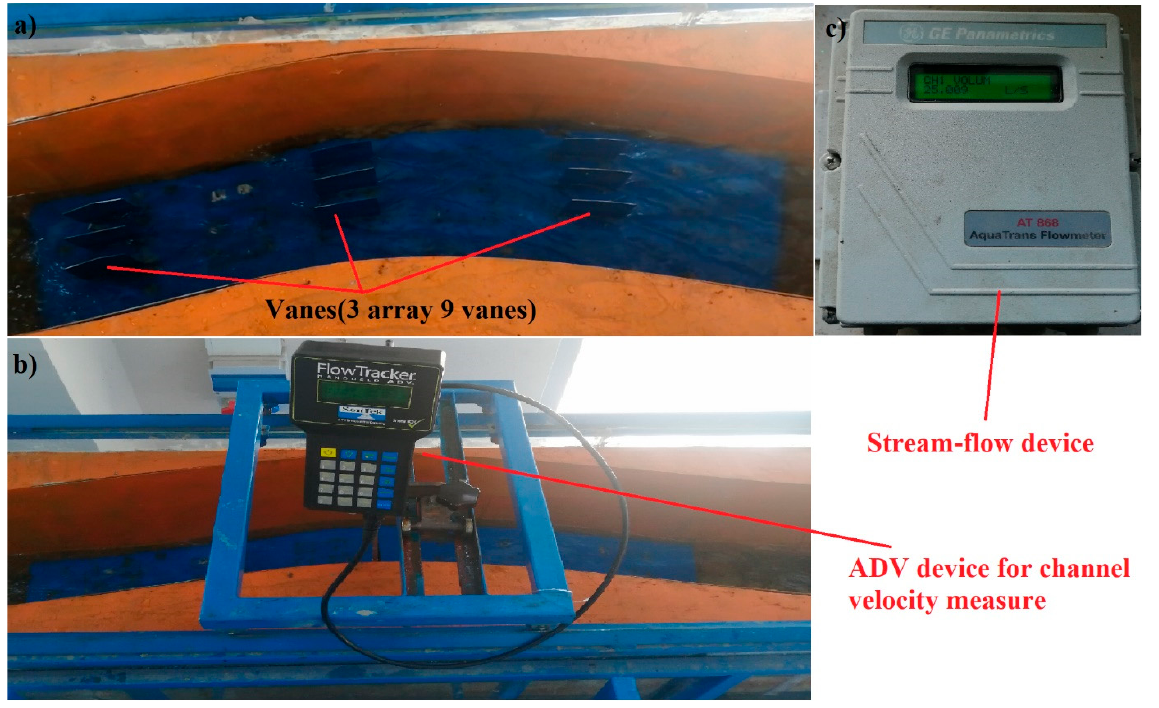
Figure 1. Experimental details for submerged vane ( a ) “with vane” situation ( b ) ADV device for velocity determination ( c ) Flowmeter for channel flow.